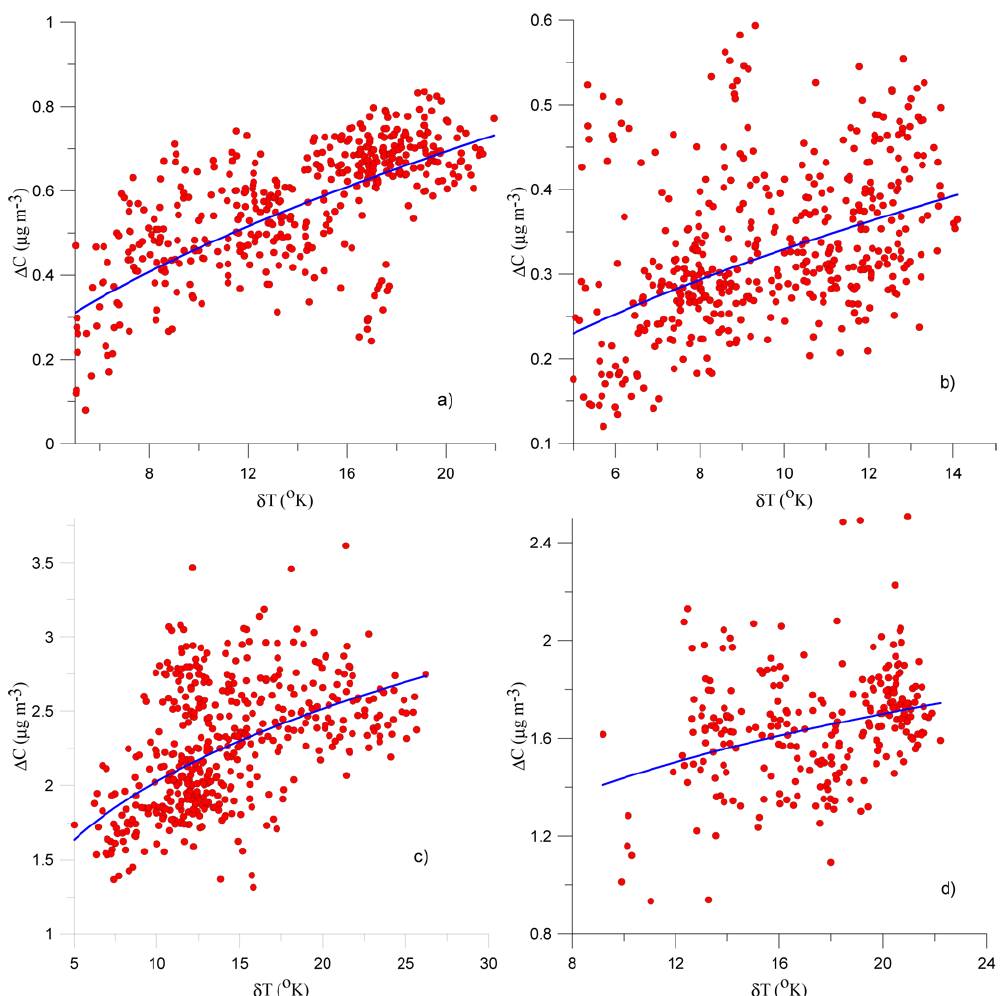
Fig. 4. Deviations of the aerosol mass concentrations recorded at a height of 0.5m from those recorded at a height of 2-m (for 2007) and 1.5-m (for 2009) (µgm − 3 ) for particles 0.15–0.5µm in size (for 2007) and 0.15–1.0µm (for 2009) as a function of the temperature difference δT between the ground surface and 0.2m. (a) data of 29 July 2007; the 2-m daytime averaged wind speed is 2.4ms − 1 , and u ∗ < 0 . 2ms − 1 ; the smooth line corresponds to the approximation 1C ∼ δT 0 . 58 ; (b) data of 28 July 2007; the 2-m wind speed is 2.8ms − 1 , and u ∗ < 0 . 3ms − 1 ; the smooth line denotes 1C ∼ δT 0 . 52 ; (c) data of 24 July a.m. 2009; the 2.2-m wind speed is 2.0ms − 1 (in the morning), and u ∗ < 0 . 2ms − 1 ; the smooth line – 1C ∼ δT 0 . 33 ; (d) data of 26 July a.m. 2009; the 2.2-m wind speed is 3.0ms − 1 , and u ∗ < 0 . 3ms − 1 ; the smooth line denotes 1C ∼ δT 0 . 24